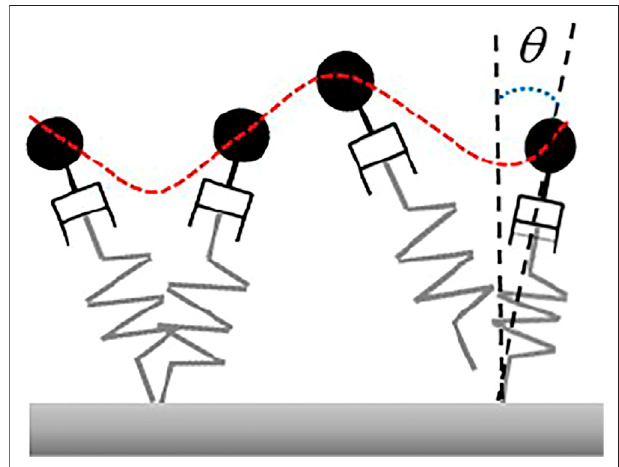
FIGURE 4 | aSLIP model. This model combines the SLIP model with a virtual linear actuator. θ is the angle between the inverted pendulum and the vertical axis.